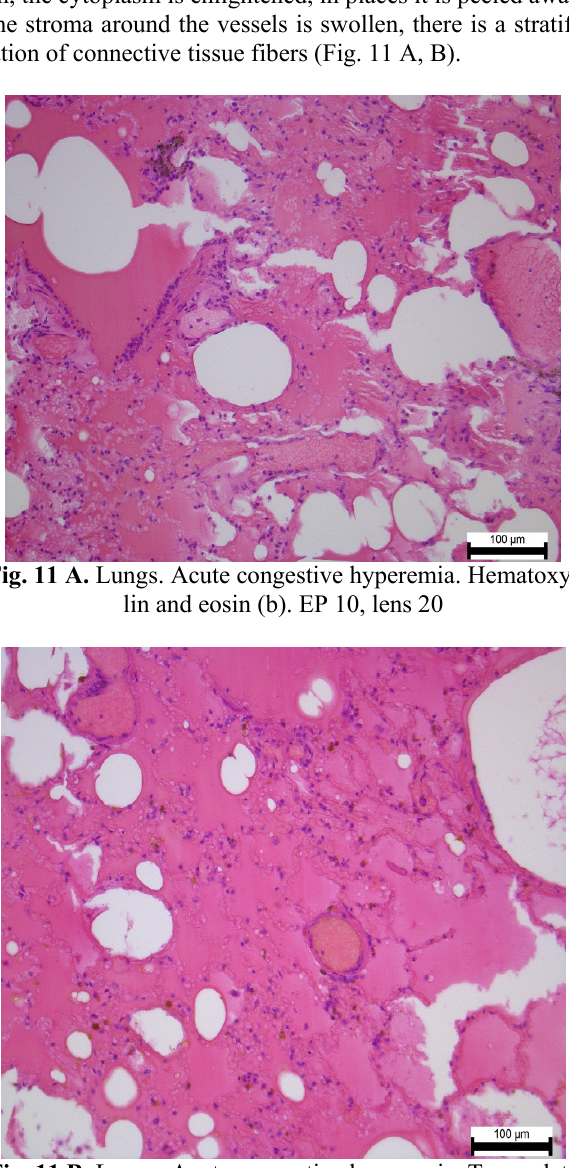
Fig . 11 B. Lungs. Acute congestive hyperemia. Transudate and erythrocytes filled the lumen of the alveoli. Hematoxy- lin and eosin (b). EP 10, lens